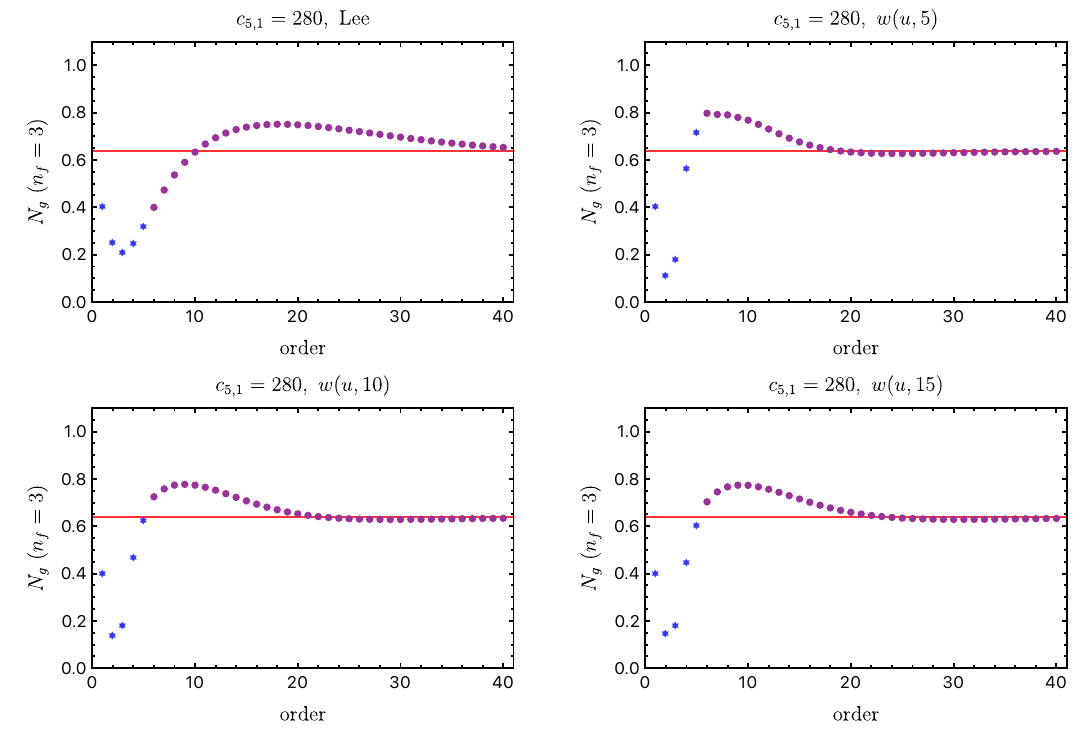
Figure 1 . Series for the n f = 3 GC renormalon norm N g up to order 40 obtained from the conformal mapping approach using the Borel model of eq. (3.1). The first five orders (indicated by the blue markers) come from the known 5-loop corrections quoted in eqs. (2.14) and the central estimate for the 6-loop coefficient ¯ c 5 , 1 of eq. (2.15). Upper left panel: results based on Lee’s mapping of eq.